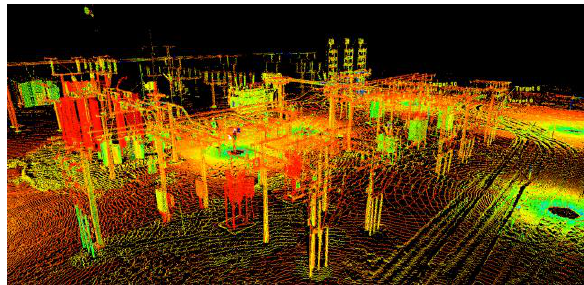
Figure 1. The registered 3D point cloud of the electrical